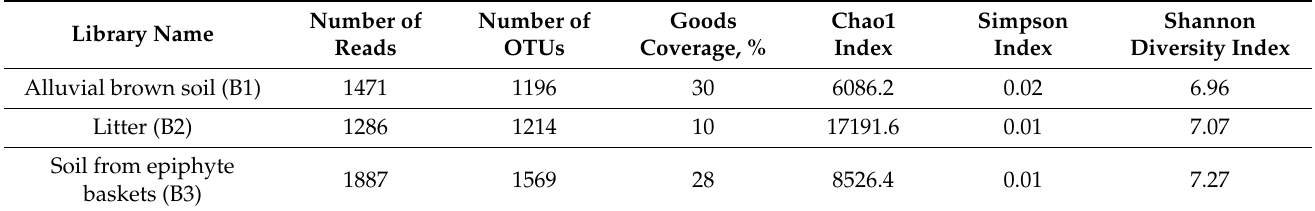
Table 3. Statistical results of sequencing of the V3–V4 region of the 16S rRNA gene.